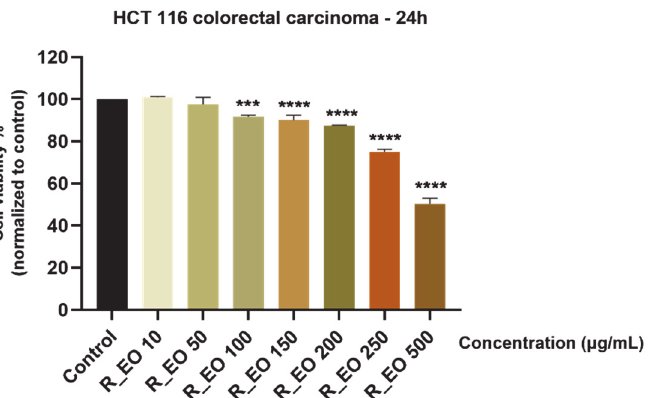
Figure 6. Viability assessment of Rosmarinus officinalis L. essential oil—R_EO (10, 50, 100, 150, 200, 250 and 500 µ g/mL) in HCT 116 cells at 24 h post-stimulation by MTT assay. The results are presented as cell viability percentage (%) normalized to control (non-stimulated) cells. These data represent the mean values ± SD of three independent experiments performed in triplicate. One-way ANOVA test was performed to determine the statistical differences in rapport with control group followed by Dunnett’s multiple comparisons post-test (*** p < 0.001 and **** p < 0.0001).